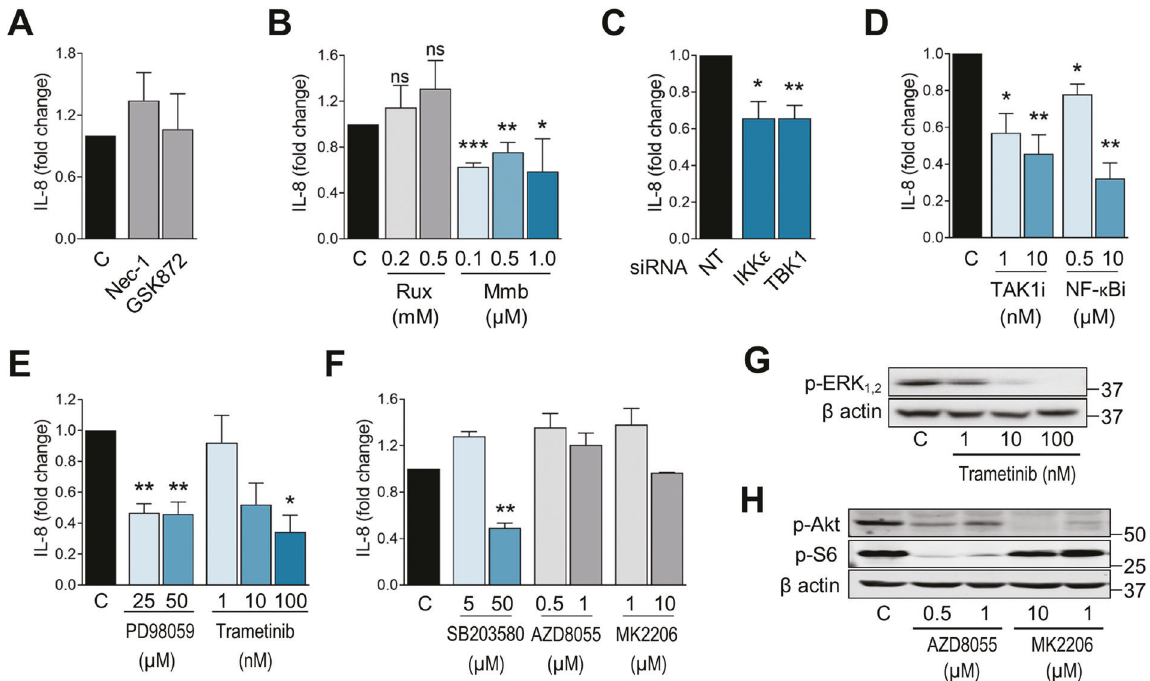
Fig. 2 NF-kappaB and MAP kinase activity promote IL-8 secretion. A A549 cells were plated and incubated with 25 mM glucose media supplemented with 10% dFBS for 24 h. Medium was replaced for fresh medium containing Nec-1 at 20 µM or GSK872 at 1 µM for 16 h. Supernatants were collected and IL-8 concentration was measured by ELISA. Results are expressed as Mean of fold change ± SEM of at least two repeats. B Same as A but using two JAK1/2 inhibitors: Ruxolinitib (Rux) and Momelotinib (Mmb) at indicated concentrations. Results expressed as Mean of fold change ± SEM (N at least of 3). C A549 cells were transfected for 24 h with nontargeting siRNA (called ’ NT ’ ) or siRNA for IKK- ε or for TBK1. Cells were left in culture for additional 24 h. IL-8 secretion was then analyzed through ELISA, expressed as Mean of fold change ± SEM ( N = 3). D A549 cells were treated with Takinib (Tak inhibitor, TAK1-i) at 1 nM and 10 nM, with BAY11-7082 (NF- κ B inhibitor, NF- κ B-i) at 0.5 µM and 10 µM and for 16 h. IL-8 secretion was measured by ELISA, results are expressed as Mean of fold change ± SEM ( N = 4). E A549 cells were treated with PD98059 (MAPKK inhibitor) at 25 μ M and 50 μ M; with Trametinib (MEK inhibitor) at 1, 10, and 100 nM for 16 h. IL-8 secretion was measured by ELISA, results are expressed as Mean of fold change ± SEM (N at least 3). F A549 cells were treated with SB203580 (p38 and Akt/ERK inhibitor) at 5 µM and 50 µM, AZD8055 (mTORC1 and mTORC2 inhibitor) at 0.5 µM and 1 µM, or with MK2206 (pan-inhibitor of Akt) at 1 µM and 10 µM for 16 h. IL-8 secretion was measured by ELISA, results are expressed as Mean of fold change ± SEM (N at least 3). G Representative western blot of p-ERK1/2 upon treatment as described in E . H Representative western blot of p-Akt and p-S6 upon treatment as described in F . Statistical analysis performed using Ratio paired t -test compared to the control sample. p -value: * p < 0.05, ** p < 0.01, *** p <